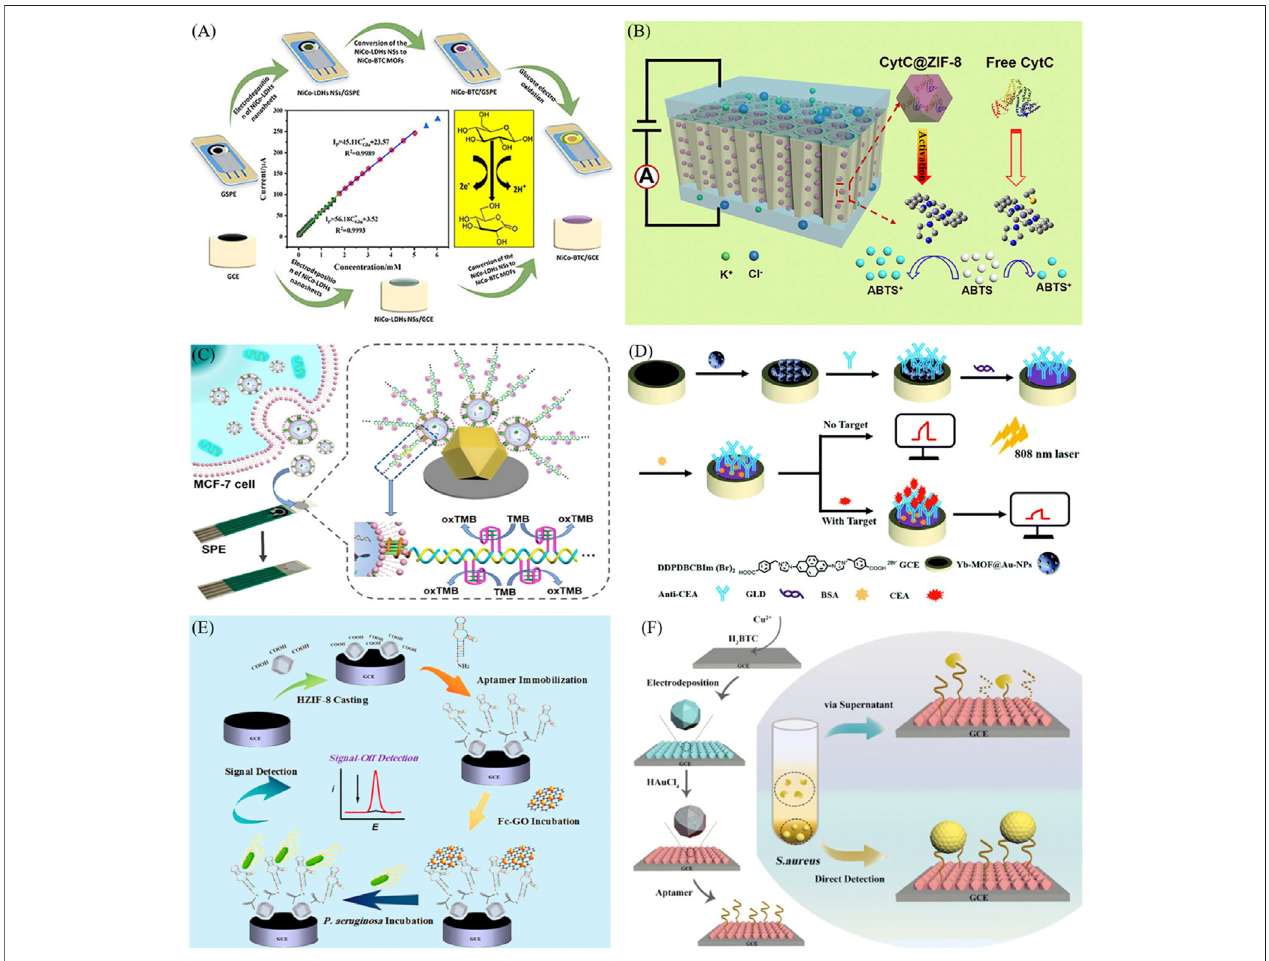
FIGURE 2 | Biosensing applications of electroactive MOF materials in previous reports. (A) Rapid in situ synthesis of bimetallic MOF on the electrodes via a two- step method enables sensitive detection of glucose (Ezzati et al., 2020). (B) Stable and ampli fi ed peroxide-like enzyme activity is obtained by growing ZIF-8 encapsulatingCytCinTiO 2 nanochannels(Guoetal.,2020). (C) Modi fi cationofUiO-66on fi berpaperpromptstheformationofDNAzymeasasignalampli fi erforsensing exosomes(Liuetal.,2021). (D) IntensephotocurrentofYb-MOF@Au-NPsinnear-infraredlightforquantitativedetectionofCEA(Lietal.,2021a). (E) Modi fi edZIF-8 solid-loaded P. aeruginosa aptamer for detection of bacteria by signal off (Shahrokhian and Ranjbar, 2019). (F) Cu-MOF fi lm enables dual detection of S. aureus and its characteristic secretions (Sun et al.,